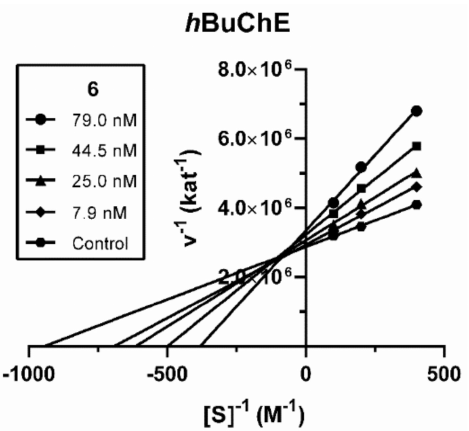
Figure 2. Steady-state mixed-type inhibition of h BuChE substrate hydrolysis by compound 6 at differ- ent concentrations. Lineweaver − Burk plots of initial velocity at increasing substrate concentrations (2.5–10.0 mM) are presented. Lines were derived from a linear regression of the data points. The intersection of lines is located above the x-axis, which means a reversible binding mode to both free enzyme and enzyme-substrate complex, with a stronger affinity to the free enzyme ( K i < K ). K m was increased whereas V max was slightly reduced at a higher i (cid:48) concentration of 6 . A K i value of 60.3 ± 11.6 nM and K of 347 ± 79 nM were measured i (cid:48) against h